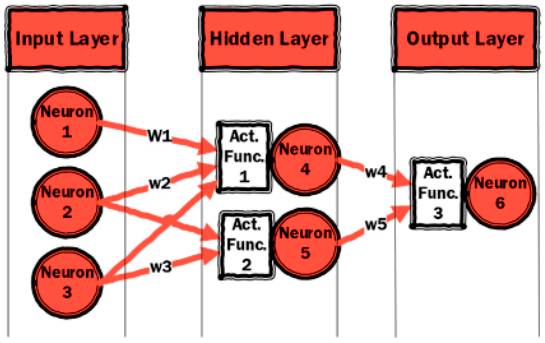
Figure 1. Basic structure within a neural network.